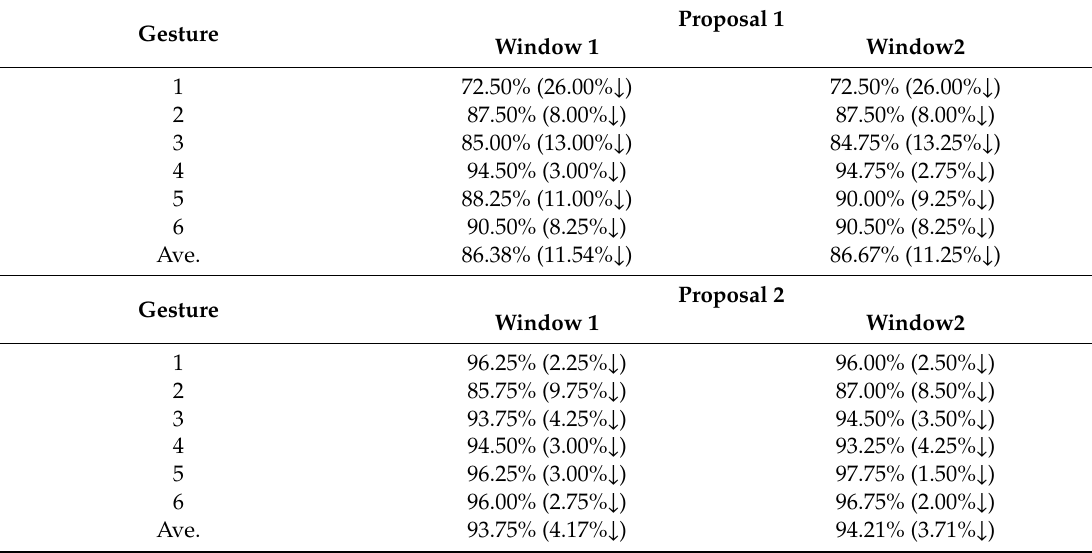
Table 9. Recognition probability of methods.